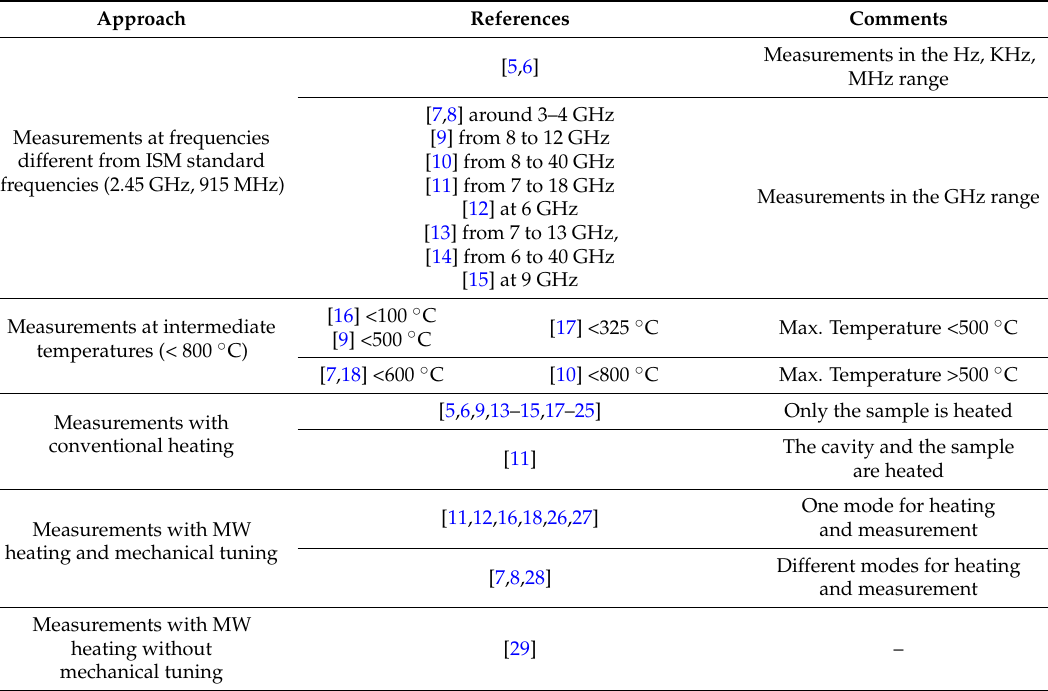
Table 1. Summary of previous work done on dielectric characterization of materials with temperature.